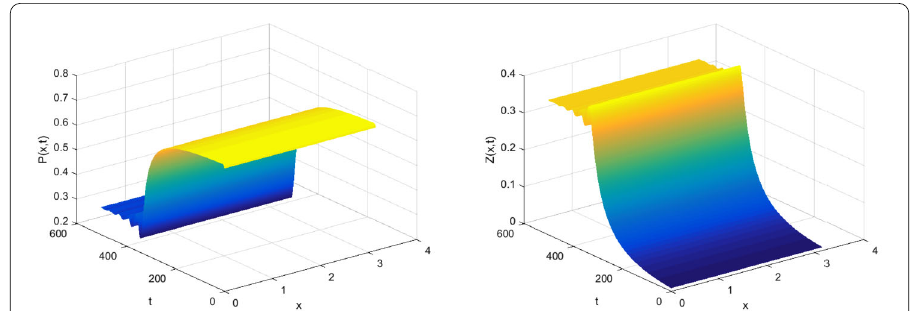
Figure 2 The numerical simulations of system (4.2) with initial condition (0.7,0.01)